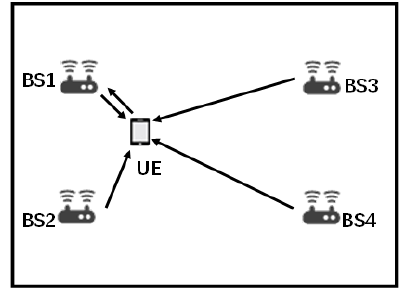
Figure 1. The system model of fifth generation (5G) system indoor positioning, base station being denoted by “BS” and user equipment being denoted by “UE”.